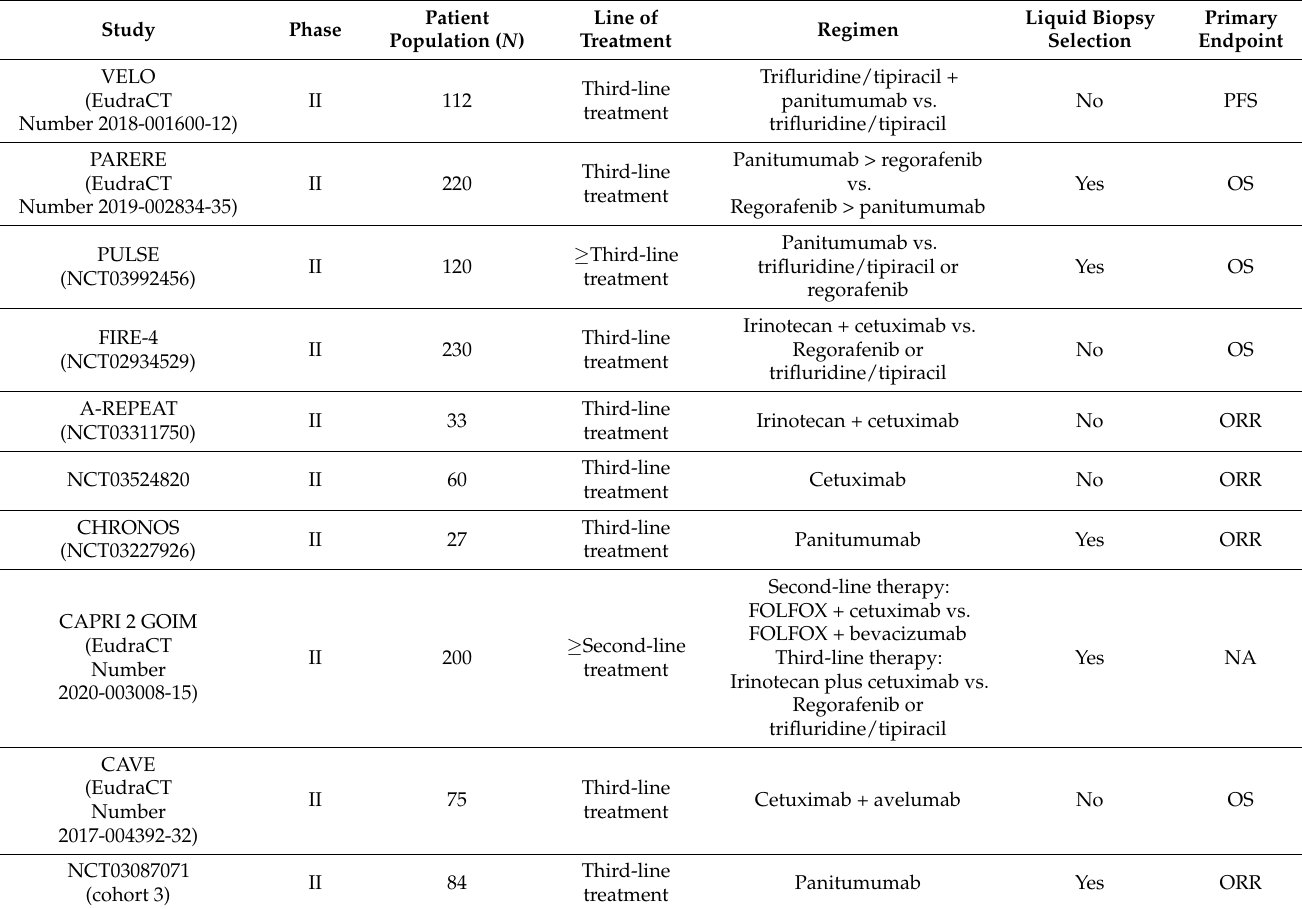
Table 2. Ongoing trials of rechallenge with anti-EGFR